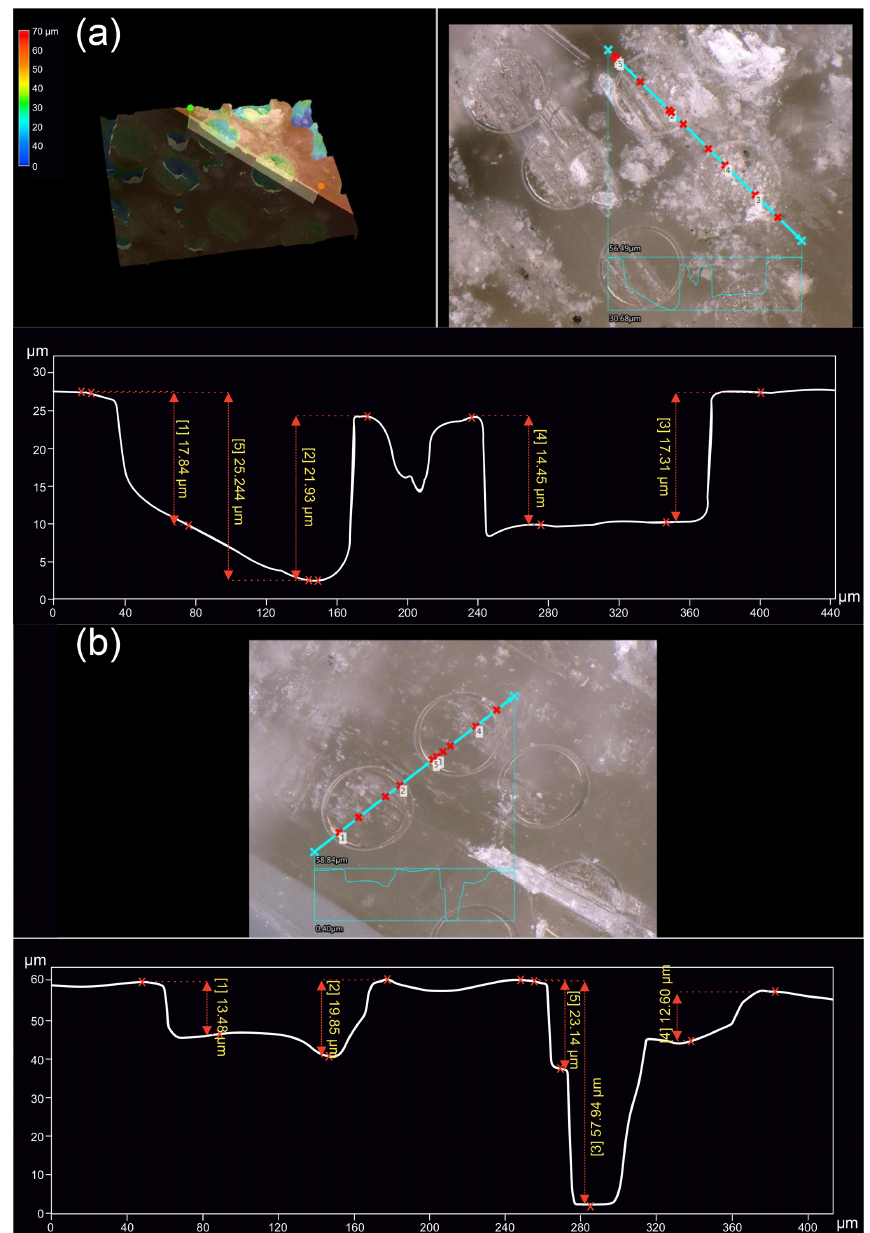
Figure 4. Pit depth profile of samples MTO 11-3 (a) and BCR 9644 (b) . Whereas the pit shape is roughly homogeneous in MTO 11-3, sample BCR 9644 displays deeper areas in some of the pits. The profiles are measured using a Keyence digital microscope